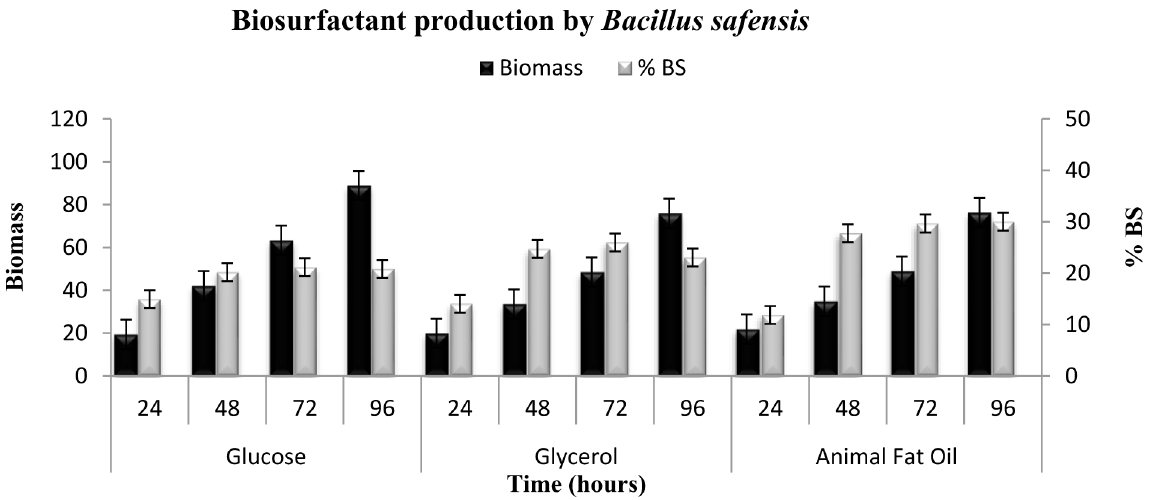
Figure 4: Time profiling for biosurfactant production by strain PWG ( Bacillus safensis ; MH142146) showed highest production on animal fat oil (22.9 g/L) while lowest biosurfactant production was on glucose (18.5 g/L). Biomasses are the mean of values recorded during production kinetics. Standard error of each value was calculated.